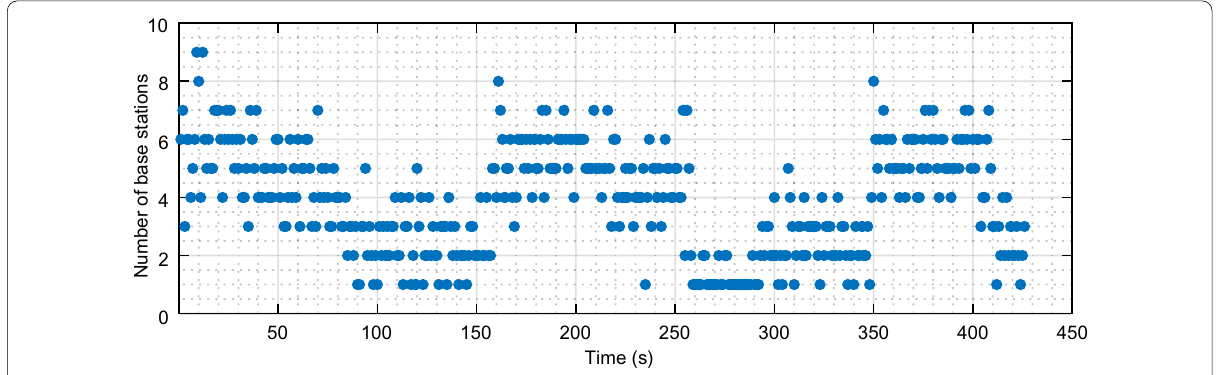
Fig. 10 Number of observable base stations in a complex